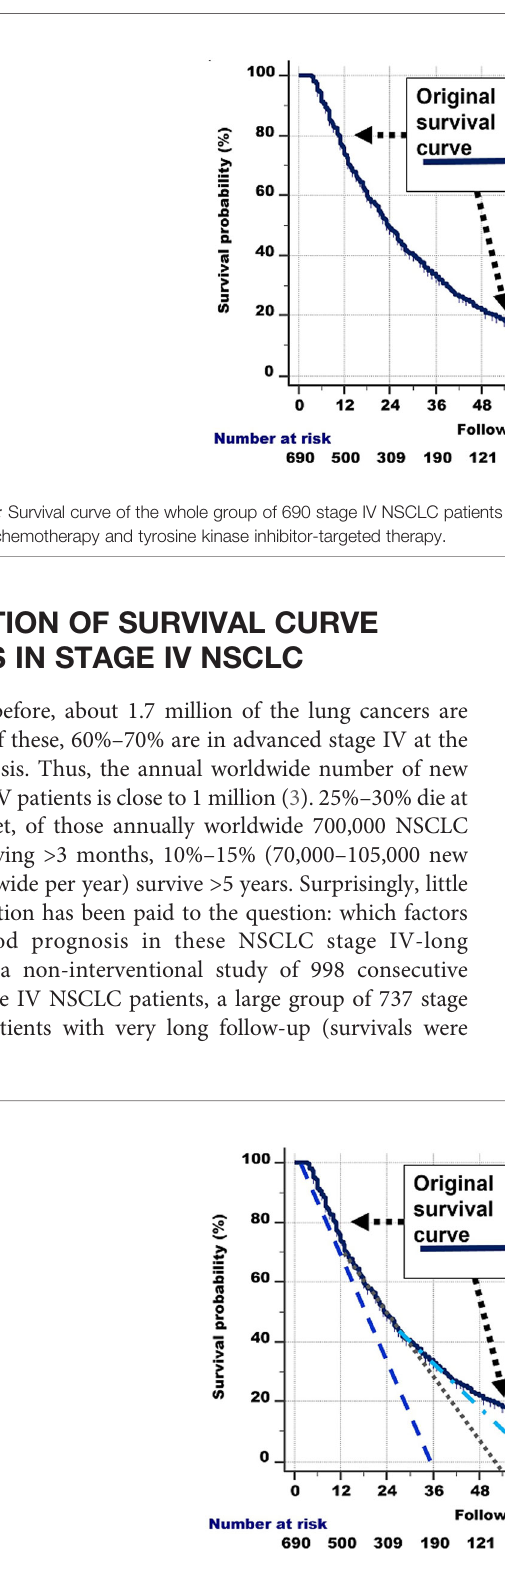
FIGURE 6 | Right: Hypothetical delineation of the curved shape of the survival curve. See the text for details. For the sake of clarity, we have only drawn 4 tangent lines instead of